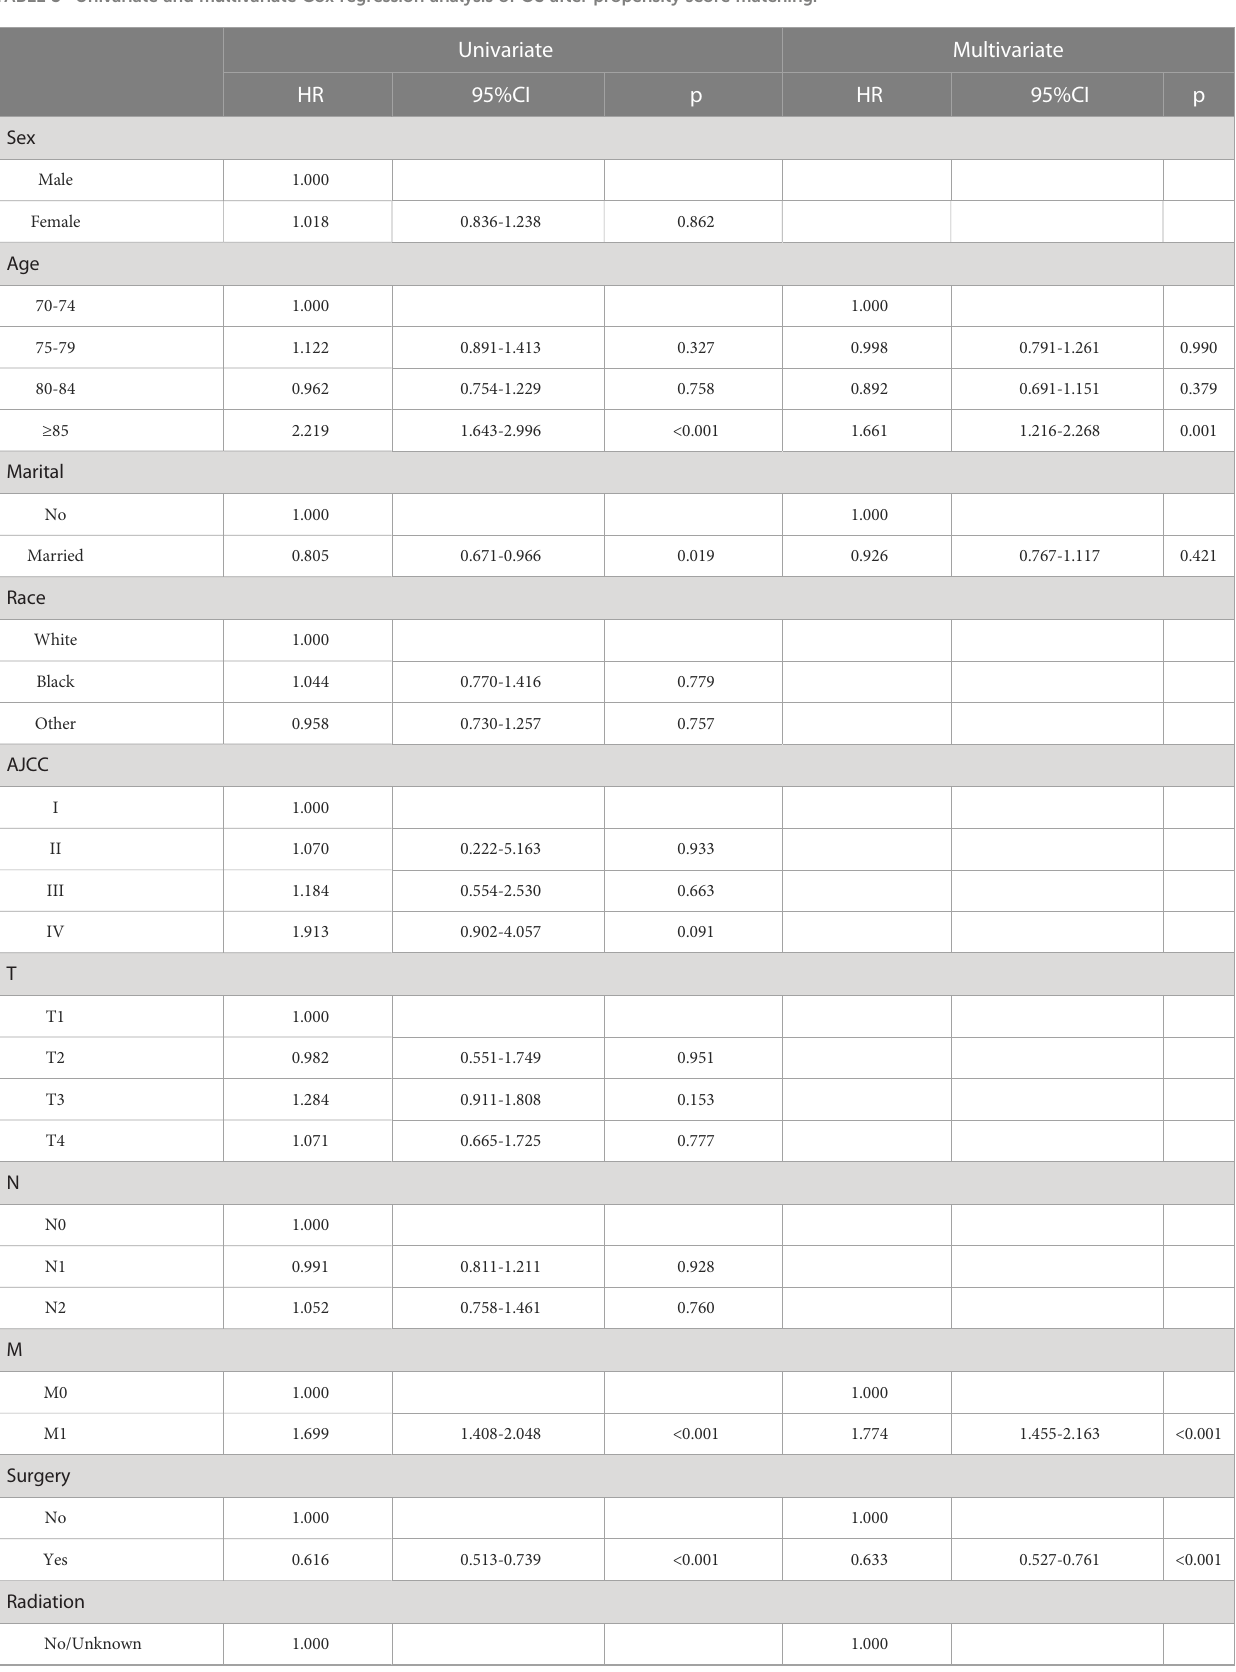
TABLE 3 Univariate and multivariate Cox regression analysis of OS after propensity score